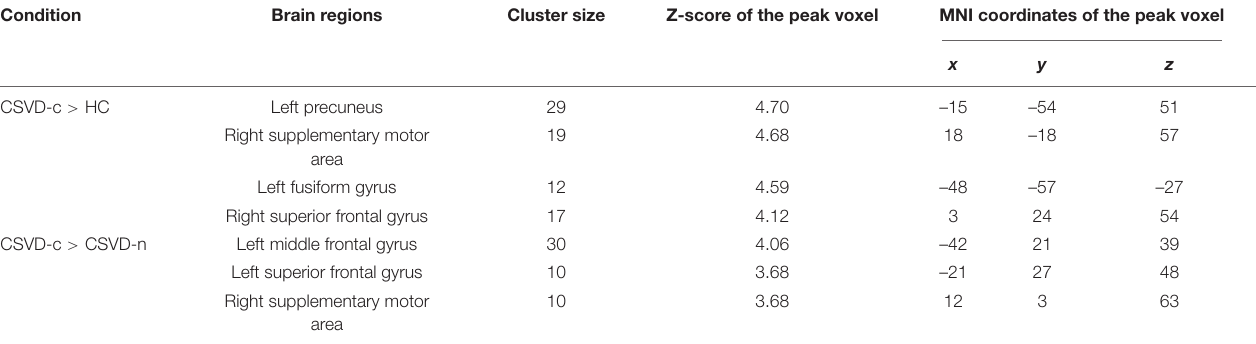
TABLE 4 | Significant differences in ReHo values among groups (ANOVA and LSD post hoc test with GRF correction, voxel-level p < 0.001, cluster-level p < 0.05). Condition